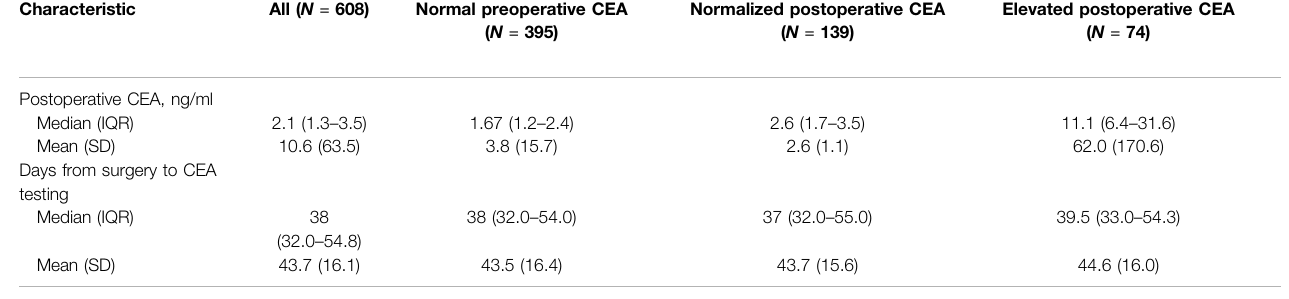
TABLE 2 | Patient with postoperative CEA characteristics. Characteristic